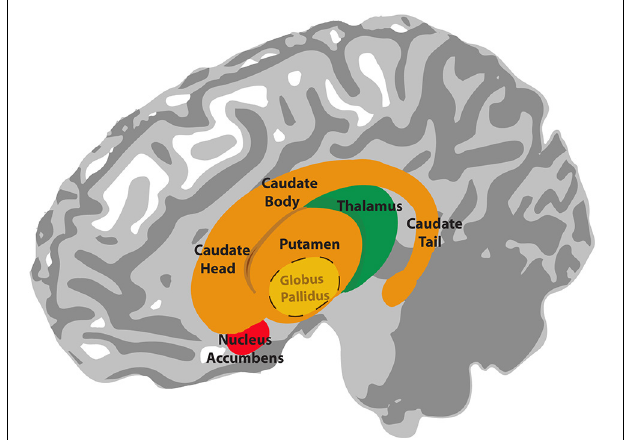
FIGURE 1 | Illustration of the anatomy of the basal ganglia. The globus pallidus lies inside the putamen. The thalamus is located underneath the basal ganglia, in the medial position of the